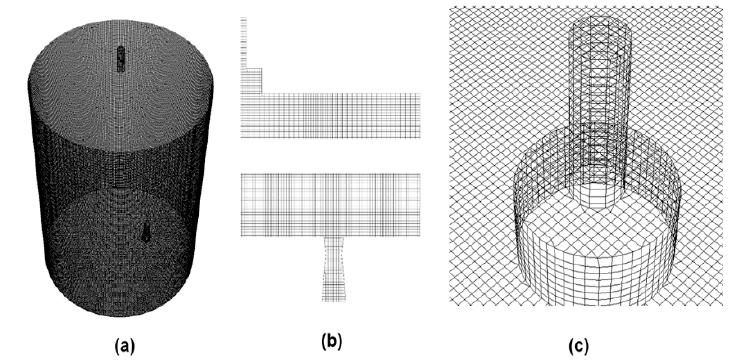
Figure 2. Computational mesh employed to solve the equations of the mathematical model through the finite volume scheme. ( a ) At the wall, ( b ) Center plane top and bottom side, ( c ) At inlet of steel.